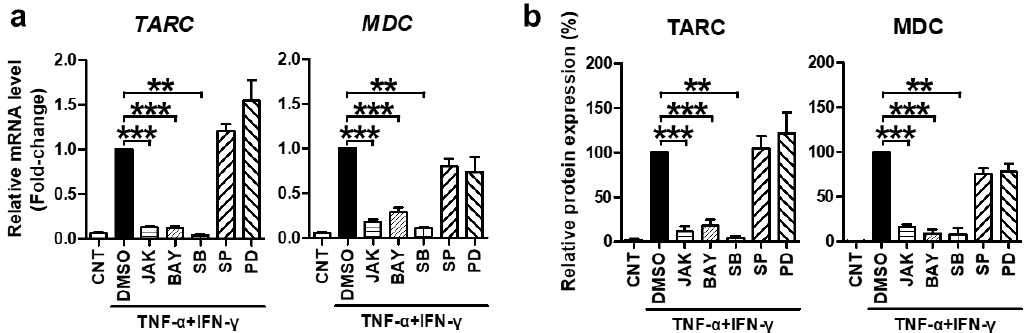
Figure 3. TNF- α /IFN- γ -induced TARC and MDC expression were mediated by STAT1, NF- κ B, and p38 MAPK. Cells were pretreated with the JAK I inhibitor (JAK, 5 µ M), BAY 11-7082 (BAY, 25 µ M), SB203580 (SB, 40 µ M), SP600125 (SP, 20 µ M), PD98059 (PD, 20 µ M), or DMSO for 30 min and then stimulated with TNF- α /IFN- γ for 18 h (for mRNA) or 24 h (for protein). ( a ) The expression of TARC and MDC mRNA was measured by quantitative real-time PCR. ( b ) Protein levels of TARC and MDC were measured using ELISA with the conditioned media. The mRNA and protein levels, relative to those in the TNF- α /IFN- γ -stimulated DMSO control samples, are presented as mean fold-changes ± SEM of independent experiments (N = 3 or 4). Statistical comparisons were performed using a one-way ANOVA followed by Bonferroni’s post-hoc test (** p < 0.01, *** p <